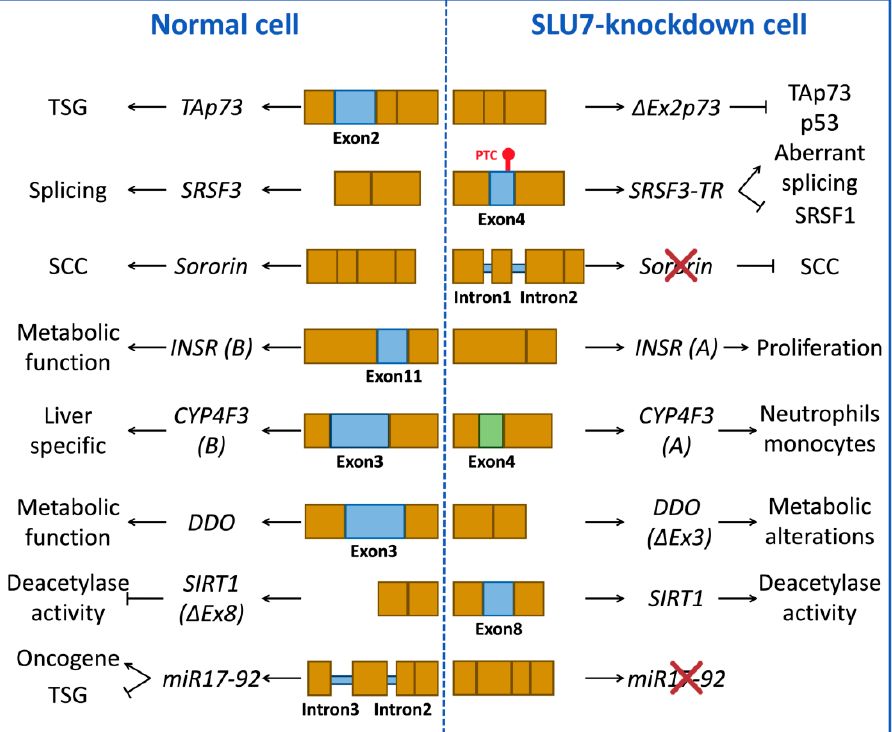
Figure 3. Splicing events in normal and SLU7-knockdown cells. Examples of constitutive and aberrant splice variants in normal and SLU7-knockdown cells and their cellular consequences. Some examples are the tumor suppressor gene TAp73 , the splicing factor SRSF3 , the gene implicated in sister chromatid cohesion (SCC) sororin , the metabolic insulin receptor ( INSR ), the metabolic enzymes cytochrome P450 ( CYP4F3 ) and D-aspartate oxidase ( DDO ), the deacetylase enzyme sirtuin 1 ( SIRT1 ) and the polycistronic microRNA cluster miR17-92 . Blue or green boxes represent the alternative exons or introns. Abbreviations: PTC, premature termination codon; SCC, sister chromatid cohesion; TSG, tumor suppressor gene; SRSF3-TR, truncated SRSF3.